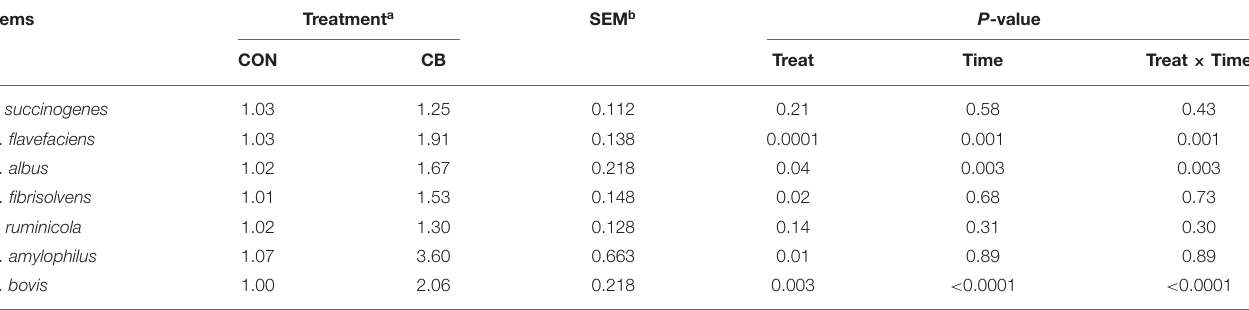
TABLE 6 | Effect of Clostridium butyricum on rumen microbiota in heifers. Items